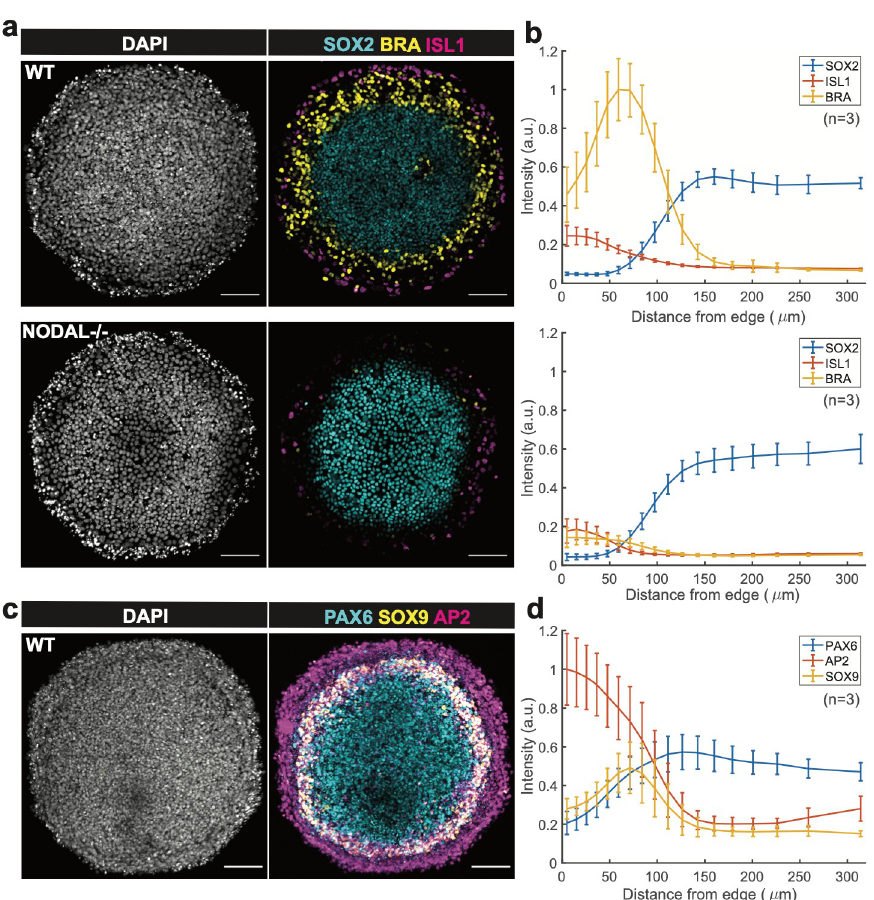
Fig 5. Reproduction of gastrulation and neural ectodermal induction results with the PEGDA-based micropatterning method. ( a ) Confocal images of cell colonies immunostained for SOX2, BRA, and ISL1 at 48 h post BMP treatment in different conditions: Control and NODAL − / − cells were treated with 50 ng/ml BMP4. BMP, Bone Morphogenic Protein. Scale bar = 100 μ m. Colony size: Diameter of 650 μ m. ( b ) SOX2, BRA, and ISL1 levels of the wild type group (top) and Nodal -/- group (bottom) were quantified as a function of distance from the colony center (n = 3). ( c ) Confocal images of cell colony immunostained for PAX6, SOX9, and AP2. Patterns were initially treated for 3 days in N2B27 media with 10 ng/mL SB and then subsequently induced for 1 day in N2B27 media with SB, BMP4 and IWP2. Scale bar = 100 μ m. Colony size: Diameter of 650 μ m. ( d ) PAX6, SOX9, and AP2 levels of the ectodermally induced group were quantified as a function of distance from colony center (n =